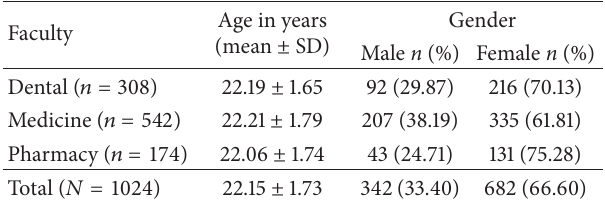
Table 1: Distribution of study subjects according to age, gender, and field of